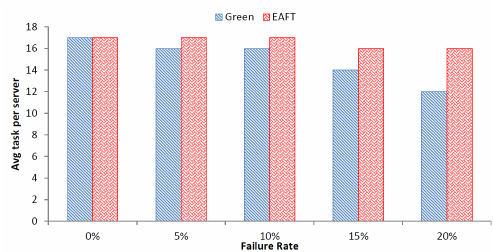
Figure 6. Impact of Failure on Average Tasks per